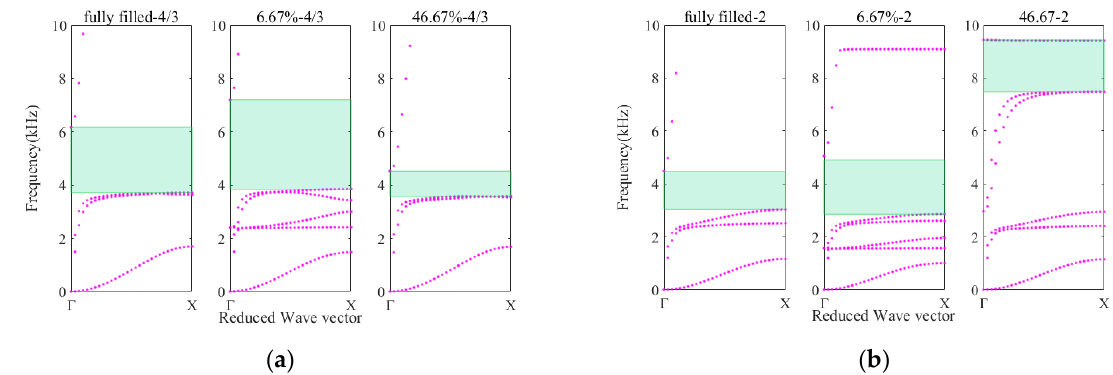
Figure 9. Dispersion curve and the value of band gap with different FR values. ( a ) The upper and lower boundary differ- ences of the first band gap. ( b ) The upper and lower boundary differences of the second band gap. ( c ) Band gap selection for the filling ratio above 40%. ( d ) Band gap selection for the filling ratio below 40.